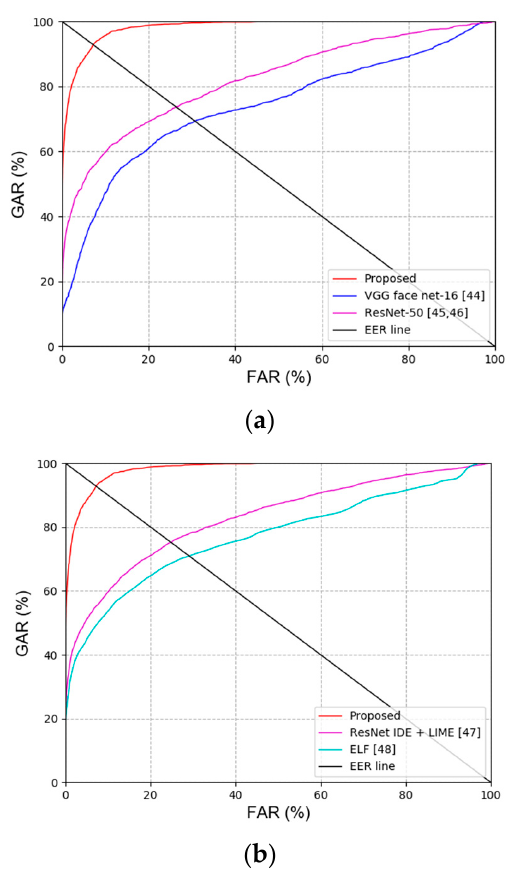
Figure 10. ROC curves acquired by the previous methods and proposed method. ( a ) Recognition results for face image, and ( b ) recognition results for body and face image.